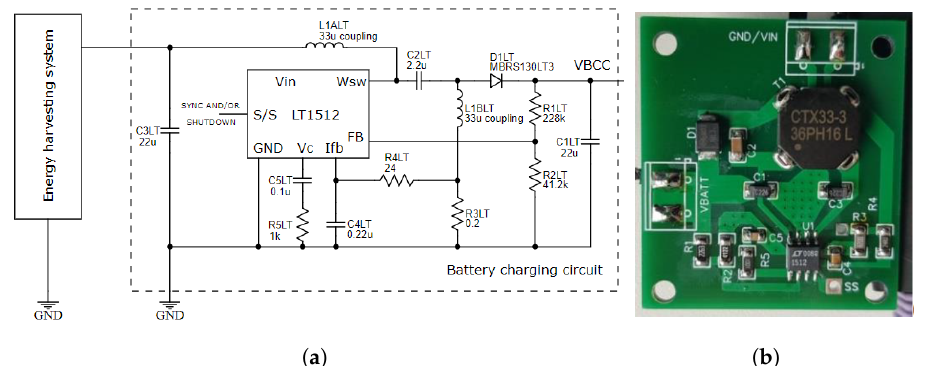
Constant current/constant voltage battery charger: ( a ) schematic of the circuit, ( b ) designed